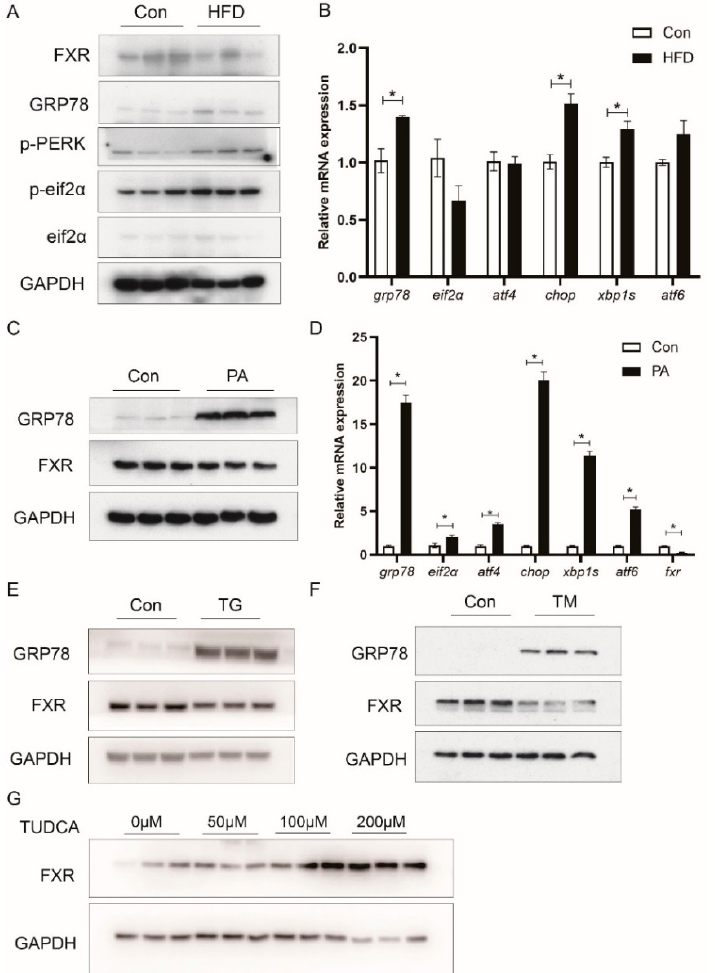
Figure 6. Effects of HFD and ER stress on the expression of FXR in large yellow croaker: ( A , B ) Immunoblots or qRT-PCR assays for FXR and ER stress markers in the liver of large yellow croakers fed HFD diet; ( C – F ) immunoblots or qRT-PCR assays for FXR and ER stress markers in LYCL cells after PA, TG, or TM treatment; ( G ) immunoblots for FXR in LYCL cells after TUDCA treatment. Data are shown as means ± SEMs ( n = 3) and were analyzed using Student’s t -test, * p < 0.05.